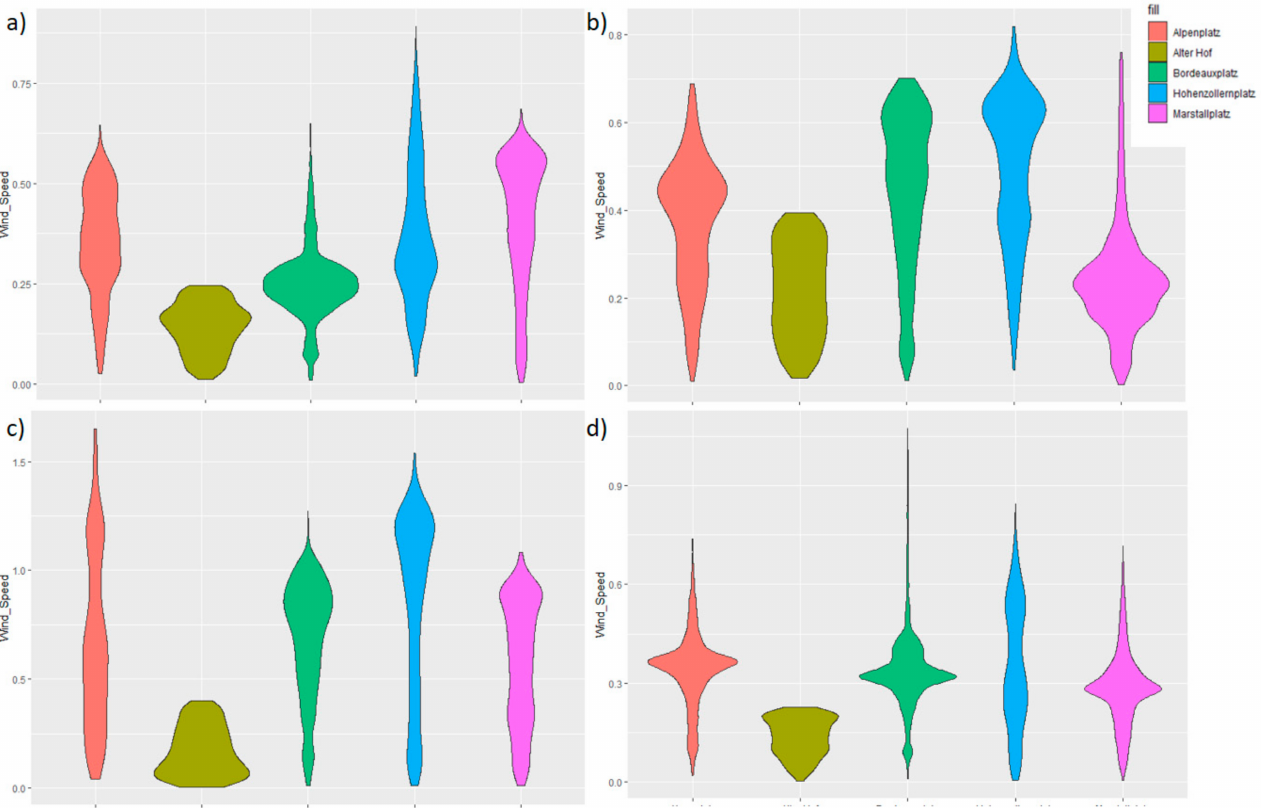
Figure 18. Wind speed comparison on the cold and humid day 2 am ( a ); 8 am ( b ); 12 pm ( c ); 4 pm ( d ). The PET of all the squares is most affected by the air temperature at 12 pm (between 66 and 85%); at other times, the variables affect the PET differently depending on the square. Only at Marstallplatz is the air temperature the variable that most affects the PET at all